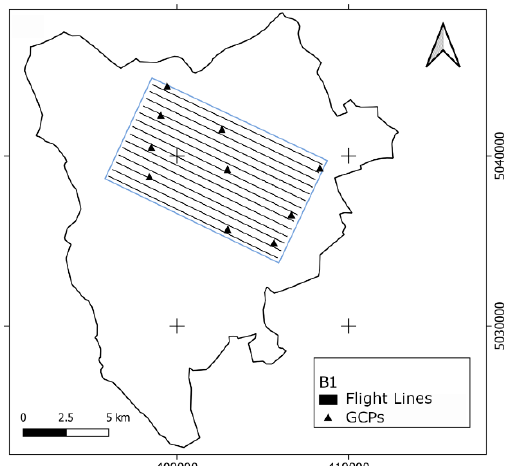
Figure 5. GCPs distribution within the B1 block (coordinate reference system is WGS 84/UTM zone 32 N). 32